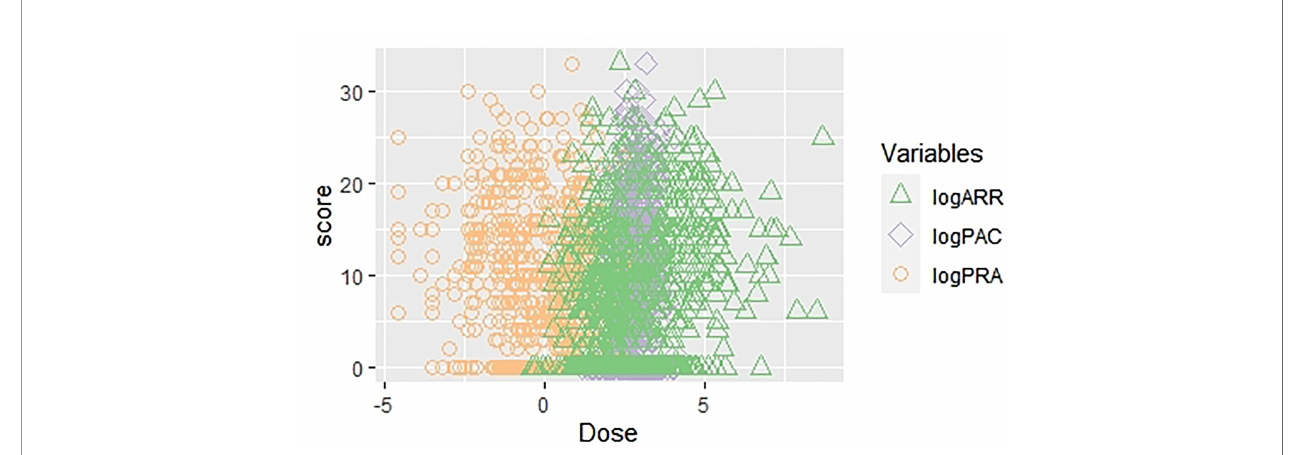
FIGURE 3 | The scatter plot regarding univariate linear regression [WMLs score vs . log(PAC), log(PRA), and log(ARR)]. WMLs, white matter lesions; PAC, plasma aldosterone concentration; PRA, plasma renin activity; ARR, aldosterone – renin ratio.